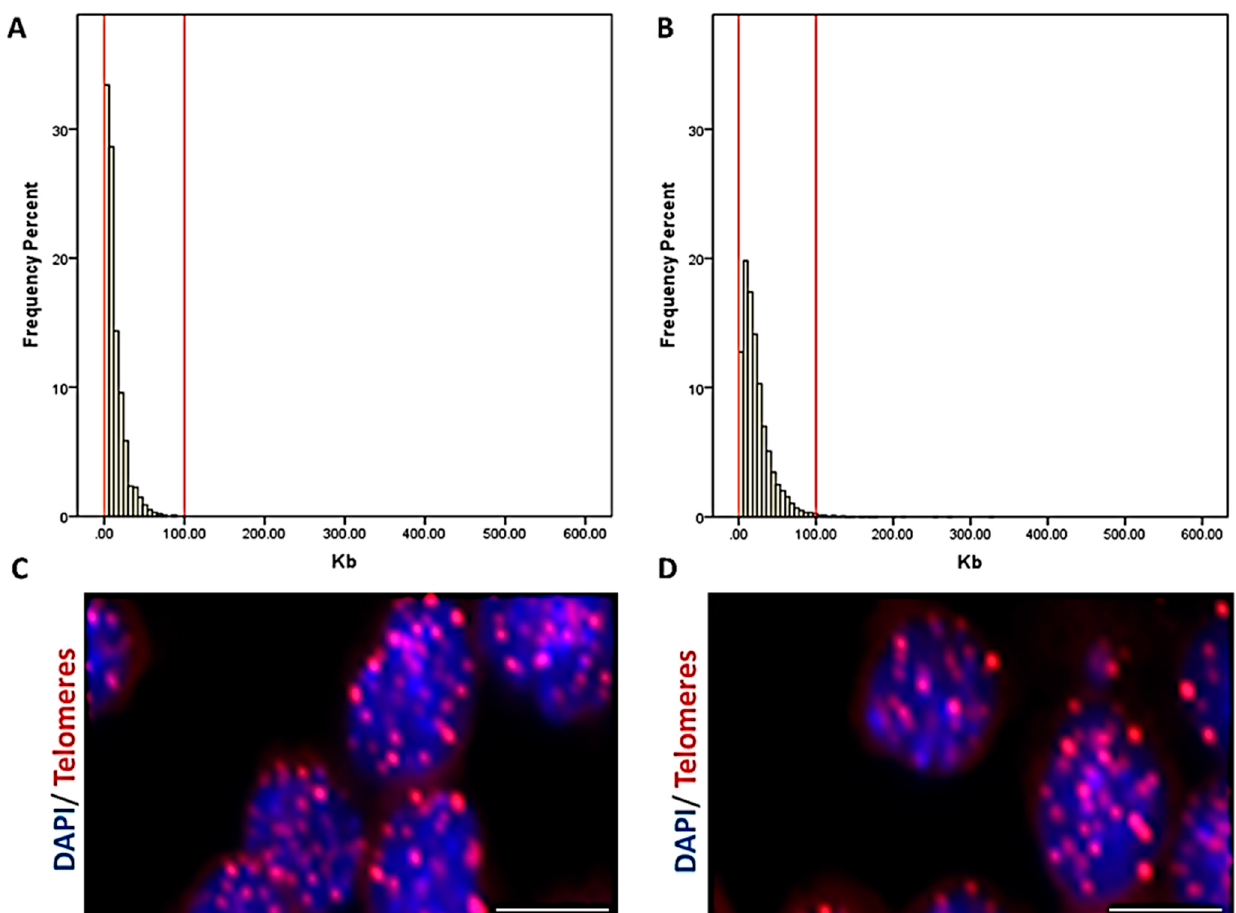
Figure 3. Telomere length in bovine peripheral blood mononuclear cells. ( A ) Representative frequency graph of telomere length distribution (a.u.) measured in the Holstein-Friesian cow blood-donor group; the mean telomere length in kb is shown. The red lines are arbitrary lines placed in the exact same position in each frequency graph to visualize differences between samples. ( B ) Representative frequency graph of telomere length distribution (a.u.) measured in the Polish Red cow blood donor group; the mean telomere length in kb is shown. The red lines are arbitrary lines placed in the exact same position in each frequency graph to visualize differences between samples. ( C ) Representative confocal microscopy picture of visualized telomeres in bovine peripheral blood mononuclear cells of the Holstein-Friesian group (blue = DAPI, red = telomeres, scale bar = 5 µ m). ( D ) Representative confocal microscopy picture of visualized telomeres in bovine peripheral blood mononuclear cells of the Polish Red group (blue = DAPI, red = telomeres, scale bar = 5 µ